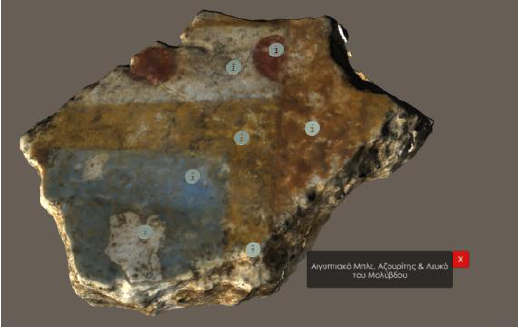
Figure 10: Application about colour information Open source software were used for the creation of the dense point cloud of the same artefact S10. Table 1 presents the number of points that each software produced during the dense